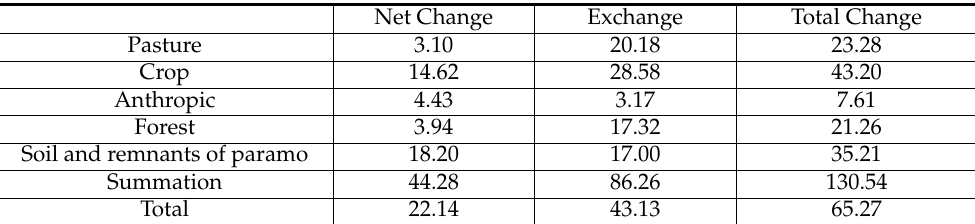
Table 6. Rate of change of the time interval of 2000–2009 expressed in percentage